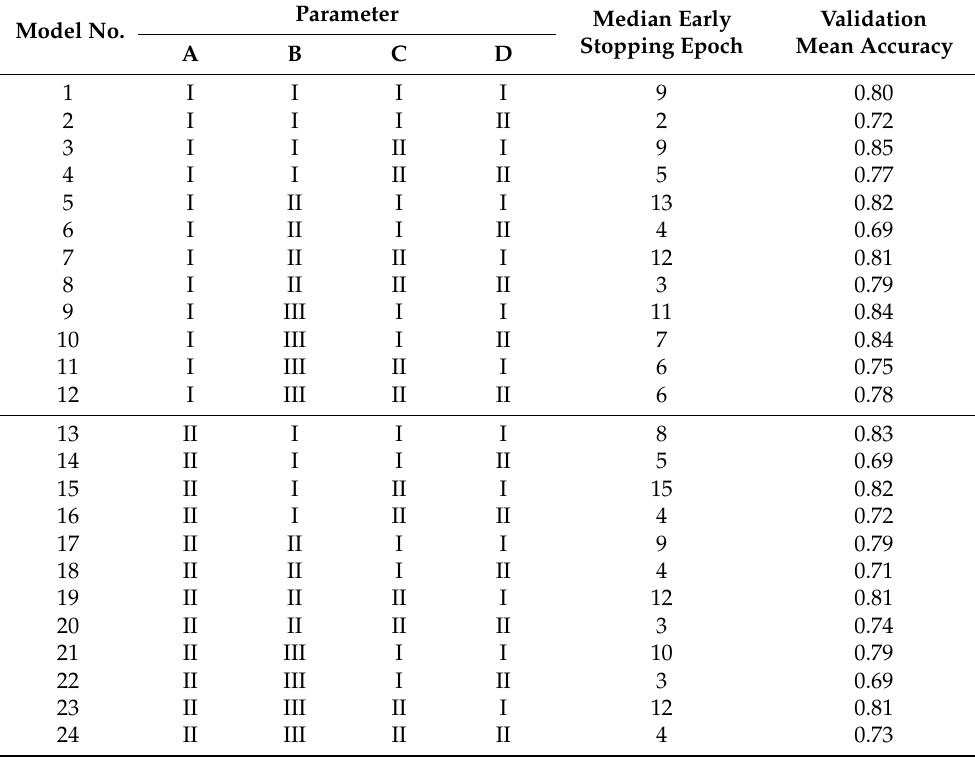
Table 6. Classification results on the validation data set for the assignment of kidneys into three functional classes depending on different training parameter combinations. The explanations for parameters A − D and I − III are given in Section 2.8. Model